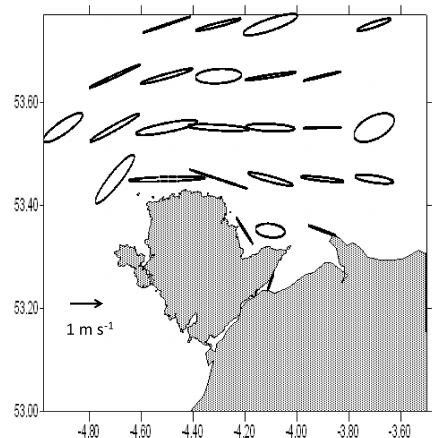
of the tide after high water at Liverpool. For a definition of the turn of the tide, see text.